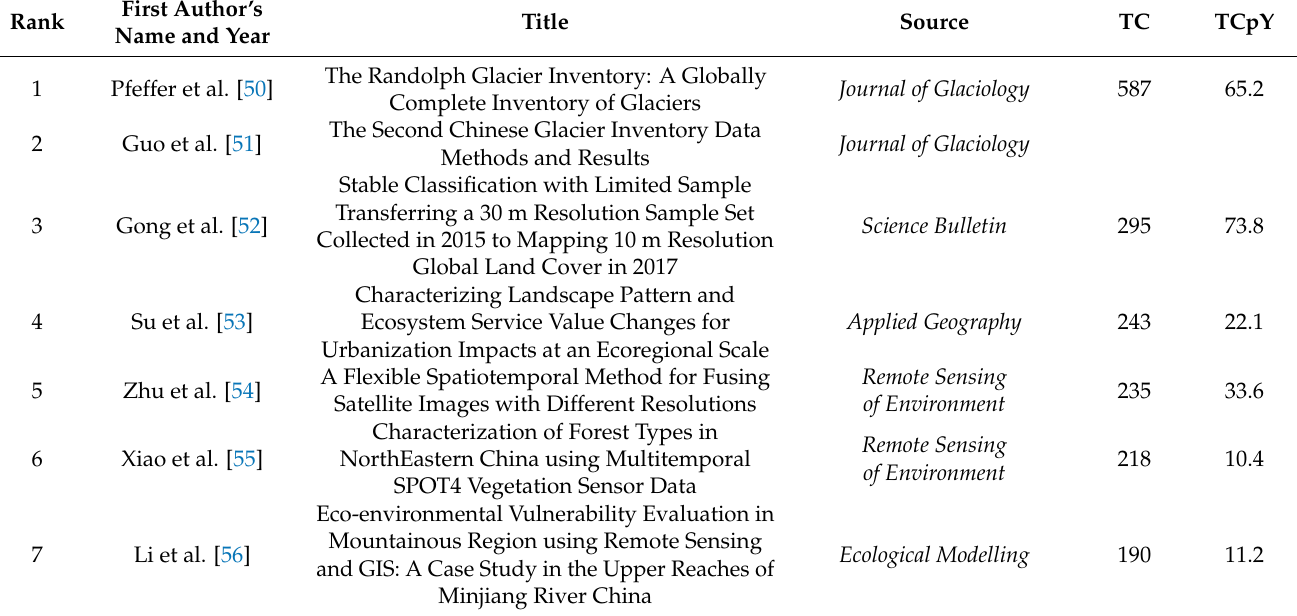
Table 3. Top 20 articles cited, corresponding author’s name, year, title, source, total citations (TC), and total citations per year (TCpY)on the application of remote sensing methods in mountainous environments.